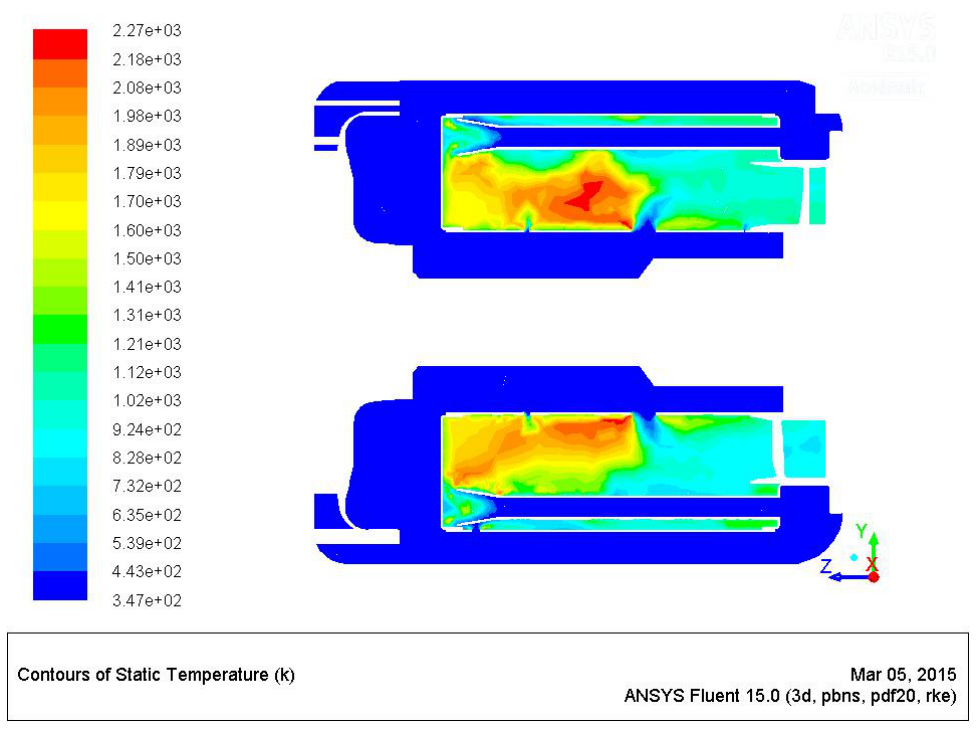
Figure 6: Static temperature contours – axial section.